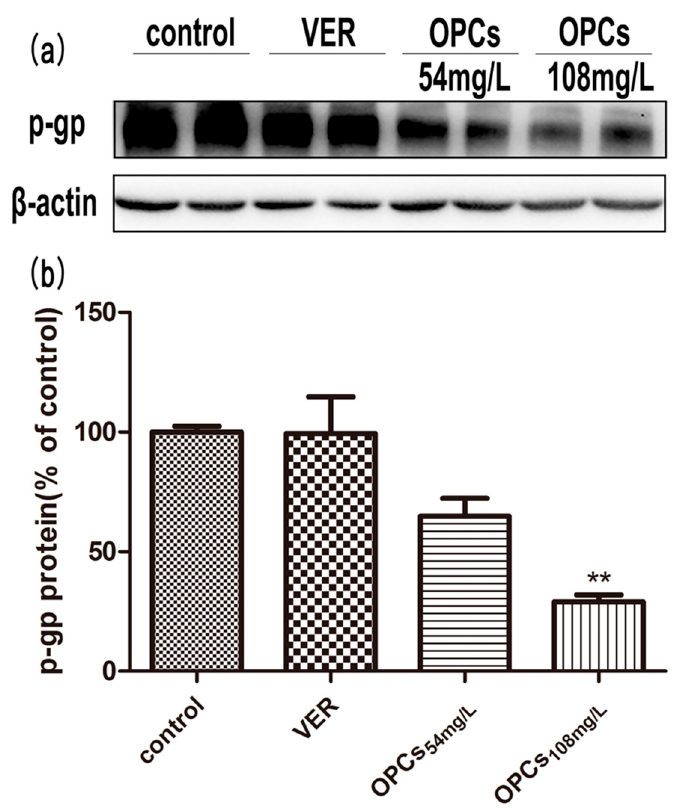
Figure 8. Effect of OPCs with different concentrations on P-gp expression for 24 h by Western blot. Representative blots were presented in the upper panel ( a ). Blots were scanned and quantified; the level of P-gp was normalized to that of β -Actin (ACTB) and plotted as percent of DMSO ( b ), which was designated as 100%. The quantitative data in histogram are presented as mean ± SEM of three independent experiments. ** p < 0.01 vs. control (DMSO).